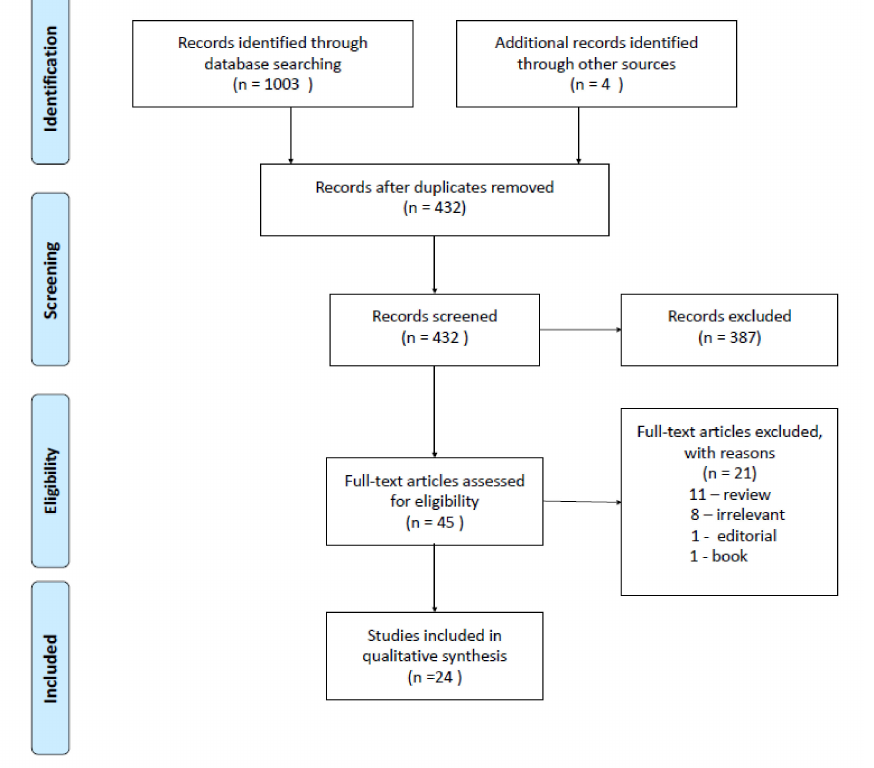
Figure 2. The PRISMA flow diagram. A total of seven exonic single nucleotide